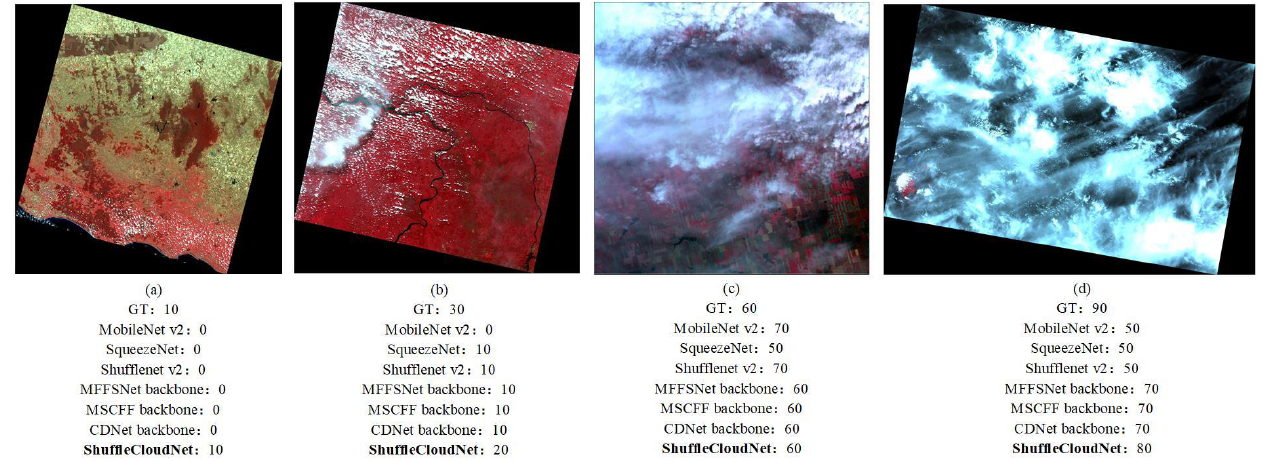
Figure 10. Test example diagram of GF-1 WFV dataset. (a) is an example of cloud amount calcu- lation results of remote sensing image with a few clouds. (b) is an example of cloud amount calcu- lation results of remote sensing image of large-scale speckled cloud. (c) is an example of cloud amount calculation result of remote sensing image of thin cloud and thick cloud mixture. (d) is an example of cloud amount calculation results of remote sensing image with multi type cloud mix- ture.